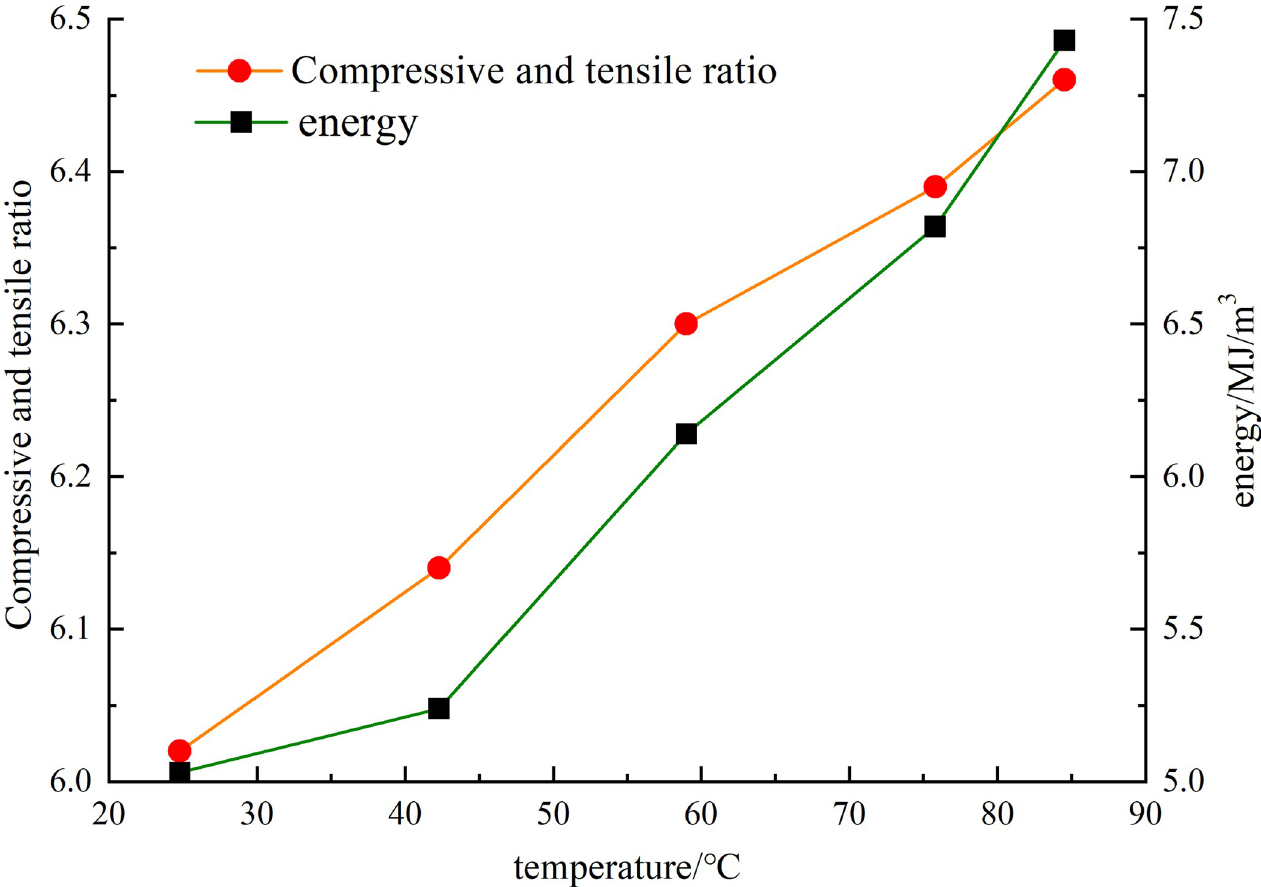
Fig 18. Variation of brittleness and energy of similar materials at different temperatures covered by the